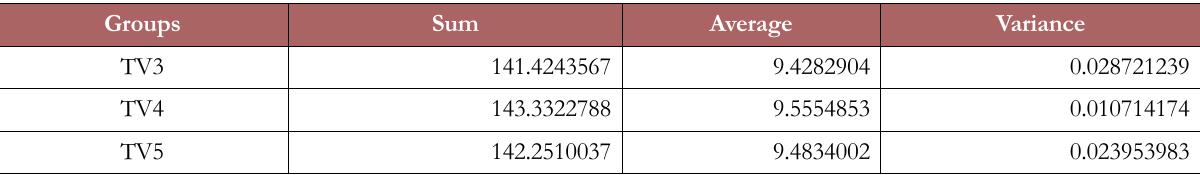
Table 9. ANOVA summary. Television sets assembly